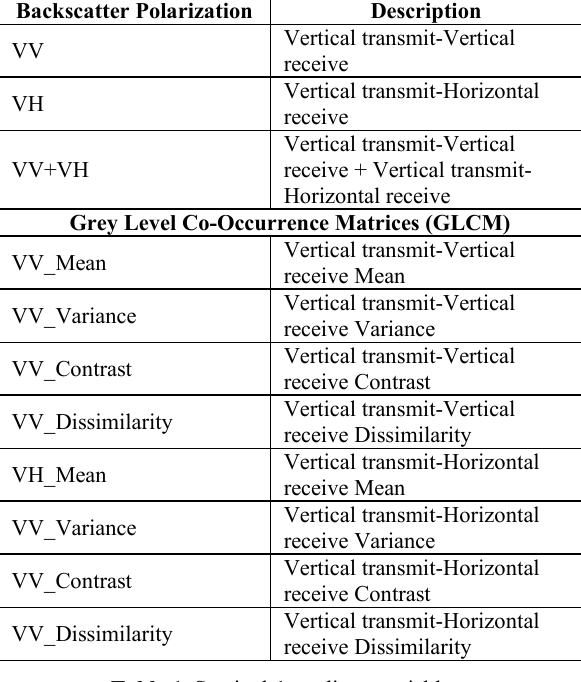
Table 1. Sentinel-1 predictor